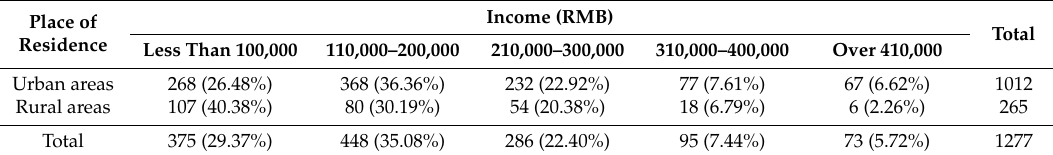
Table 4. Cross-analysis of incomes between parents from urban and rural areas in Beijing. 1 Chinese Yuan (RenMinBi, RMB) = 0.144 U.S. Dollars.